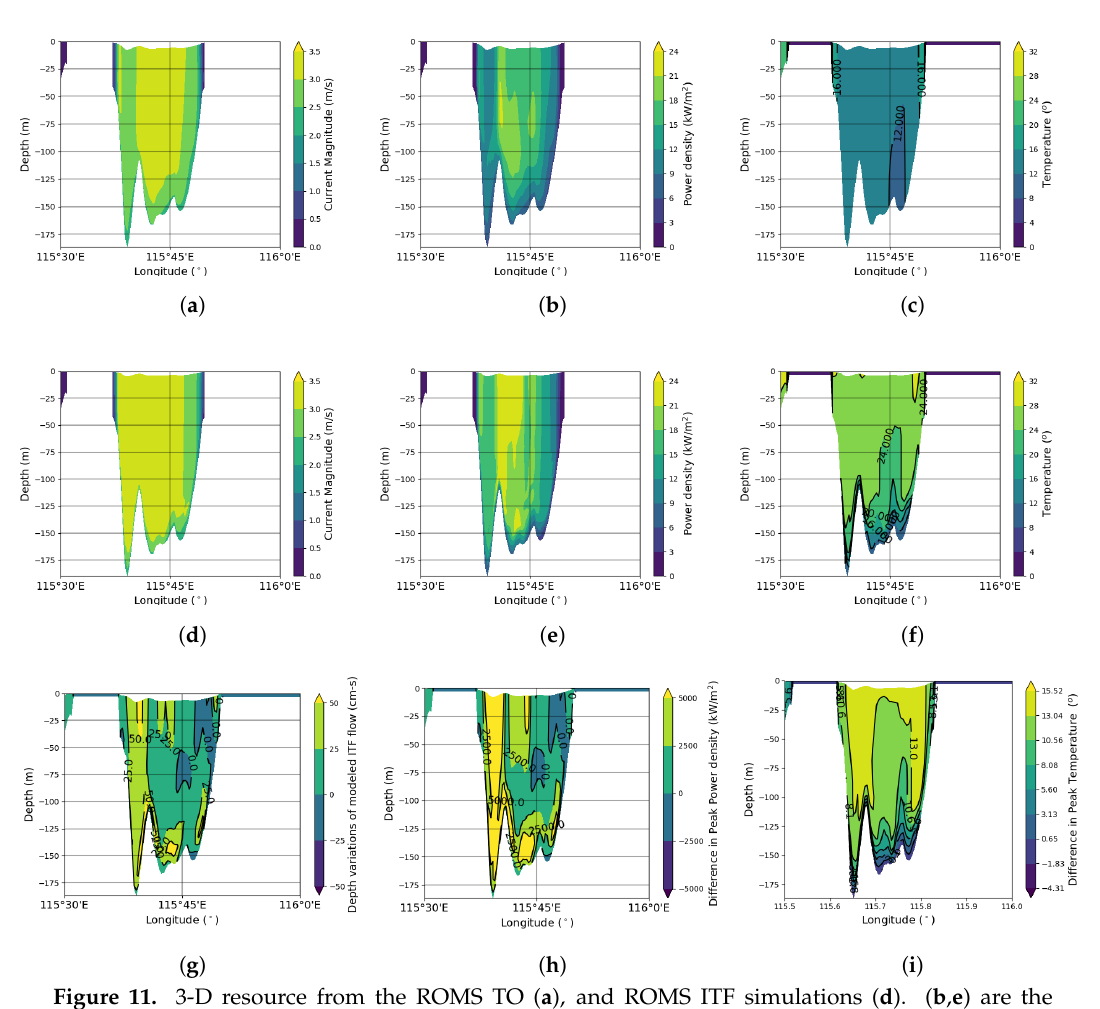
Figure 11. 3-D resource from the ROMS TO ( a ), and ROMS ITF simulations ( d ). ( b , e ) are the equivalent power densities (kw/m 2 ) and temperatures ( c , f ) within the cross section of the Lombok strait. Difference in peak resource ( g ), power ( h ) and temperature ( i ) between tide only and ITF